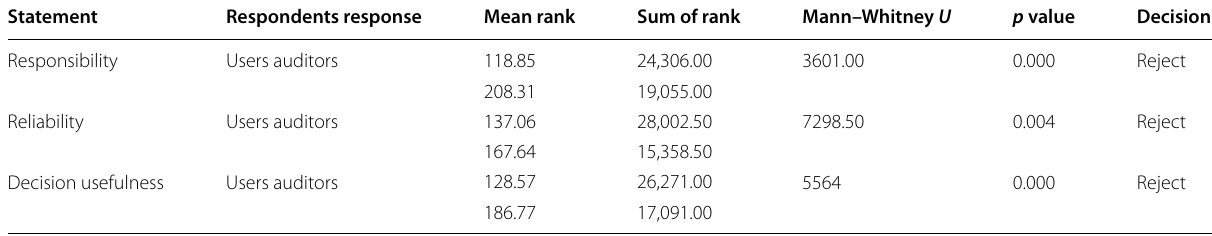
Table 6 Testing of hypothesis. Source: Survey Data Analysis (2019)